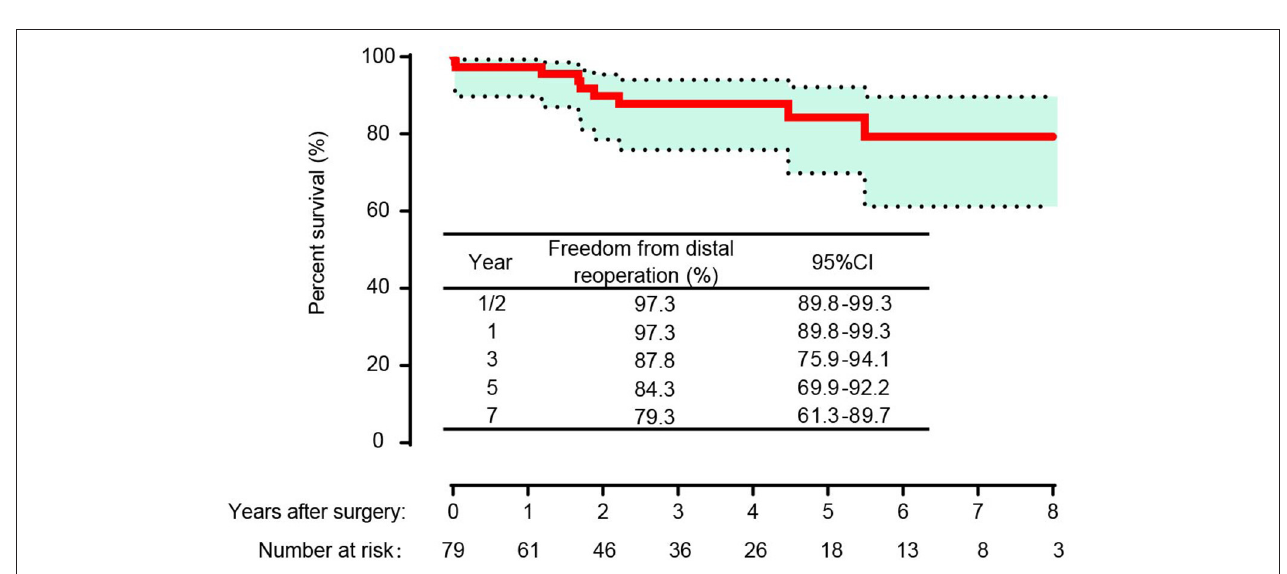
FIGURE 4 | Survival in patients with subacute and chronic type B aortic dissection and compared with the log-rank test.